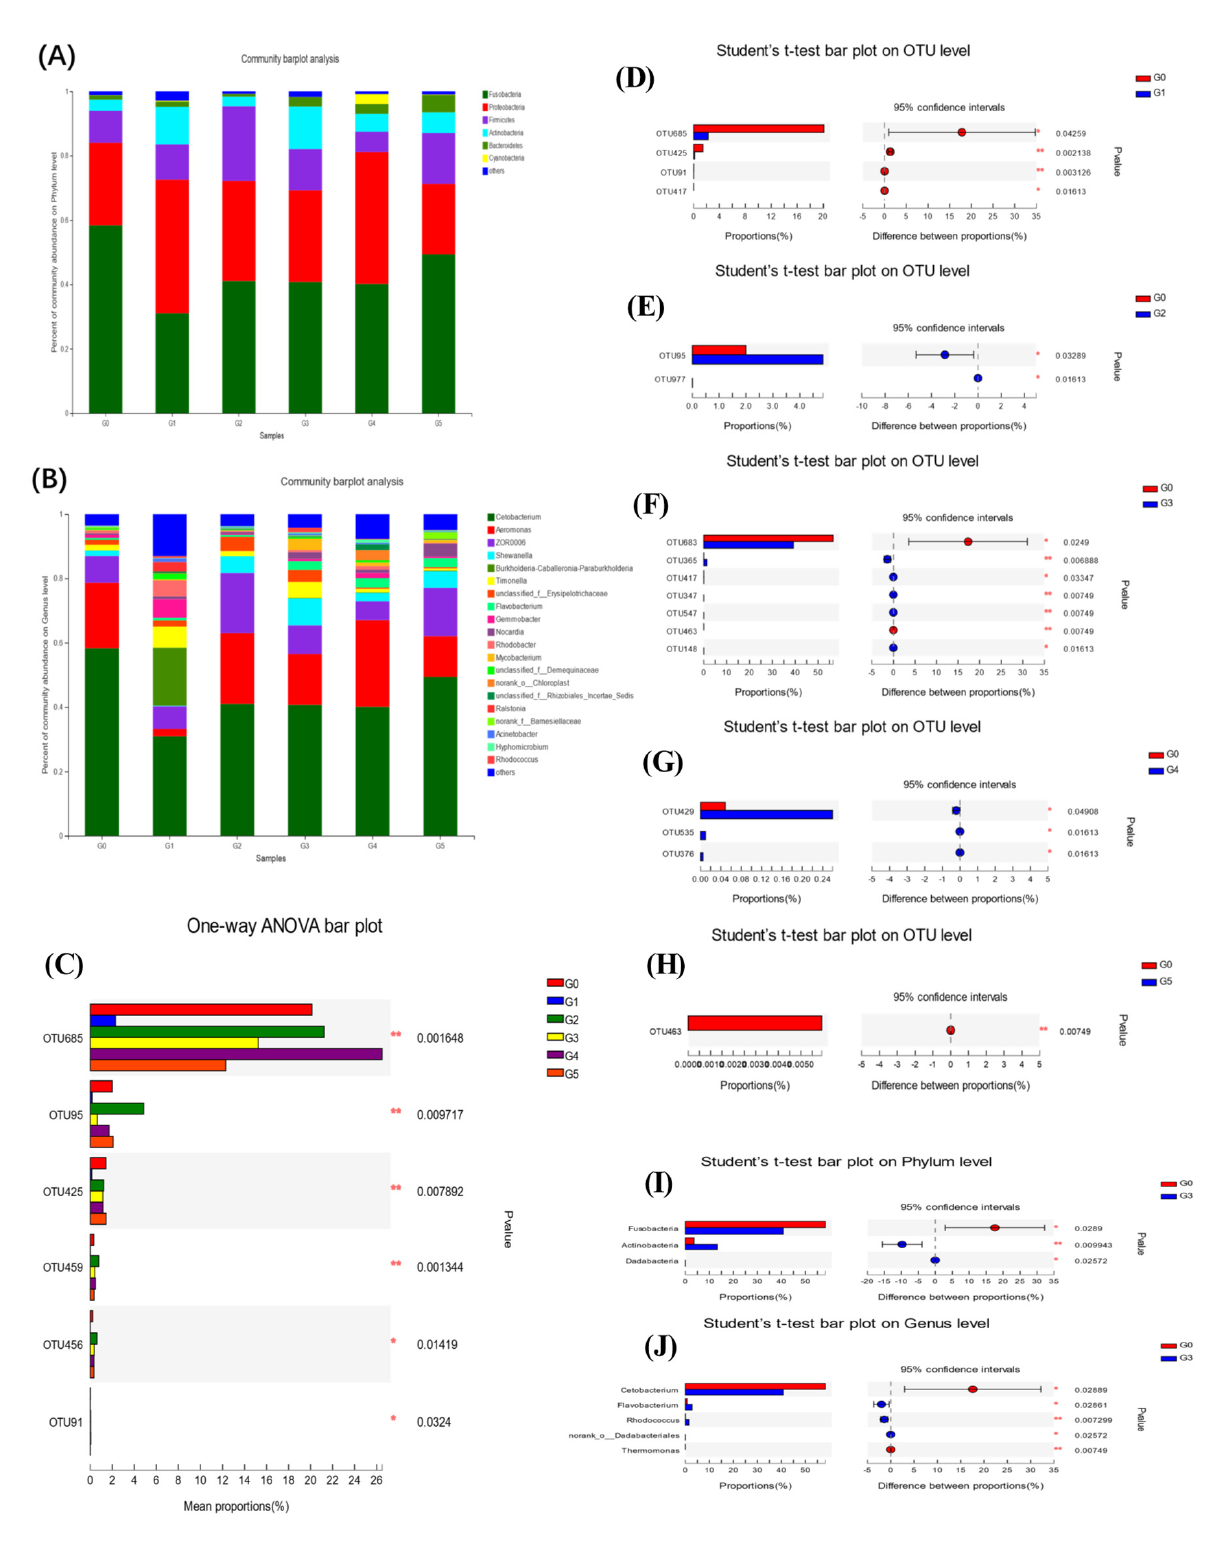
Figure 3. Comparison of the beneficial intestinal microbiota and community differences between all groups. ( A ): the phylum level; ( B ): the genus level; ( C ): the significantly different community between groups at the OTU level; ( D – H ): pairwise comparison at the OTU level; ( I ): phylum with significant difference between G3 and G0 groups; and ( J ): genus with significant difference between G3 and G0 groups. n = 3 per group. * p < 0.05, ** p < 0.01.